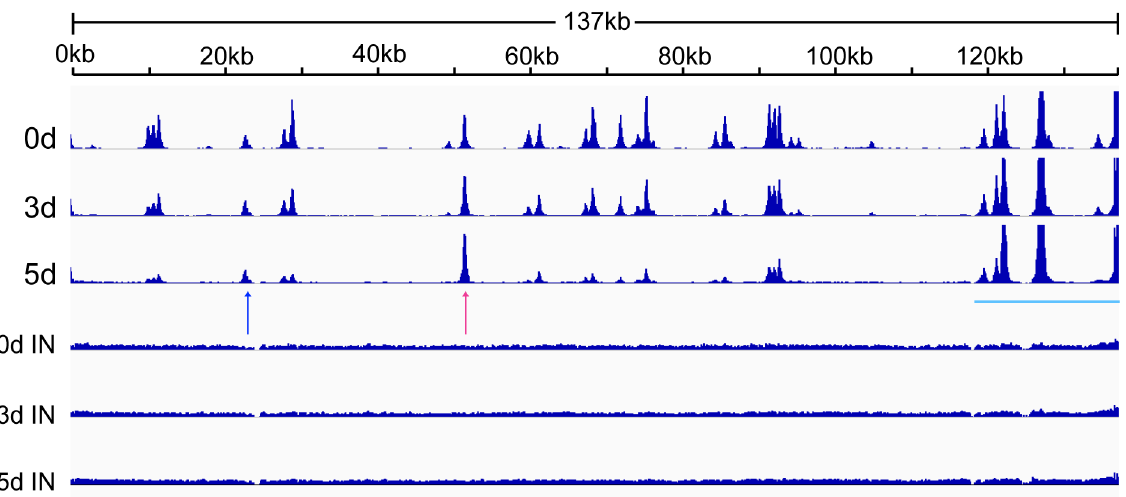
Figure 3. Changes in CTCF binding to the KSHV genome during KSHV reactivation and lytic replication. ChIP-SEQ assays were performed on cell samples obtained at 0, 3, and 5 d after induction of lytic KSHV replication in iSLK cells. Relative read numbers are plotted on the vertical axis versus the reference KSHV genome map on the horizontal axis. CTCF ChIP results for each time point are shown on the upper three panels and the corresponding input samples (IN) are shown on the lower three panels. The tracks depict coverage per base, scaled per million mapped KSHV reads. The region including the latency locus where CTCF binding is maintained is shown by a blue bar, and two additional sites of retained CTCF binding are shown by red and blue arrows (see